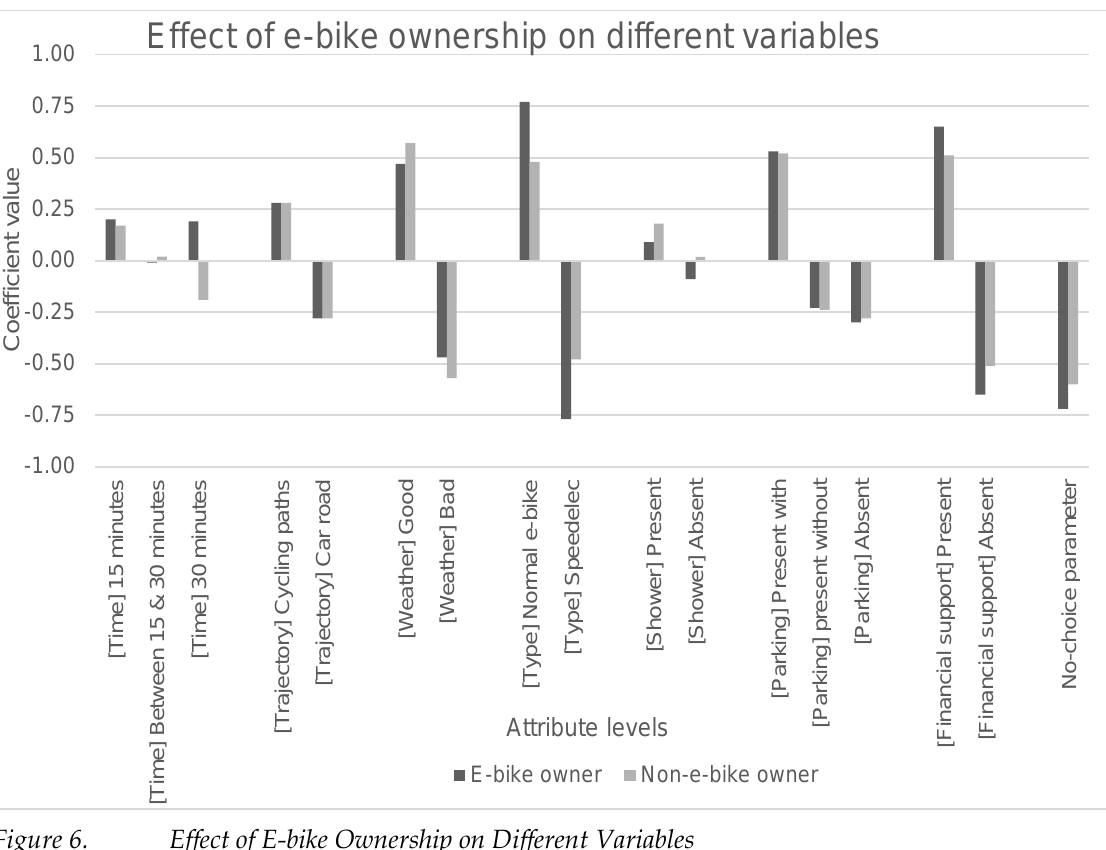
Figure 6. Effect of E-bike Ownership on Different Variables